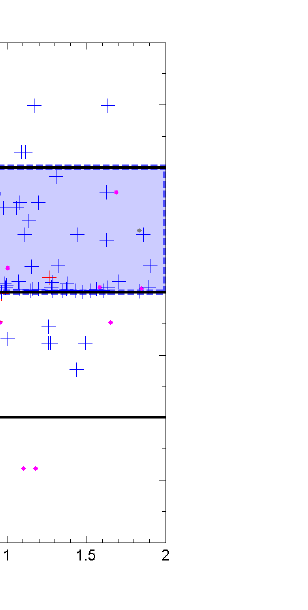
Figure 11. L vs. R B . The blue box represents where both L and R B agree on the stable conditions; the percentage (24%) represents the percentage of data points in this box. The red box represents where both L and R B agree on the unstable conditions; the percentage (11%) represents the percentage of data points in this box. Includes data filtered for tower 80m wind speeds between 3.5 and 25ms − 1 , 87m wind directions between 235 and 315 ◦ , and for normal turbine operation.